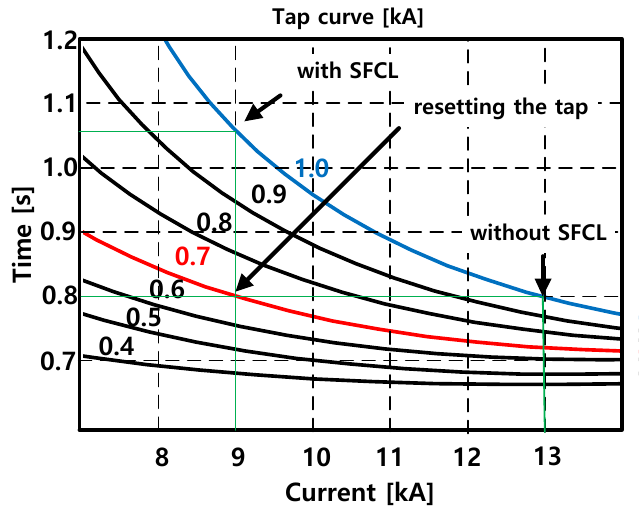
Figure 14. Operation time characteristics of the OCR according to the